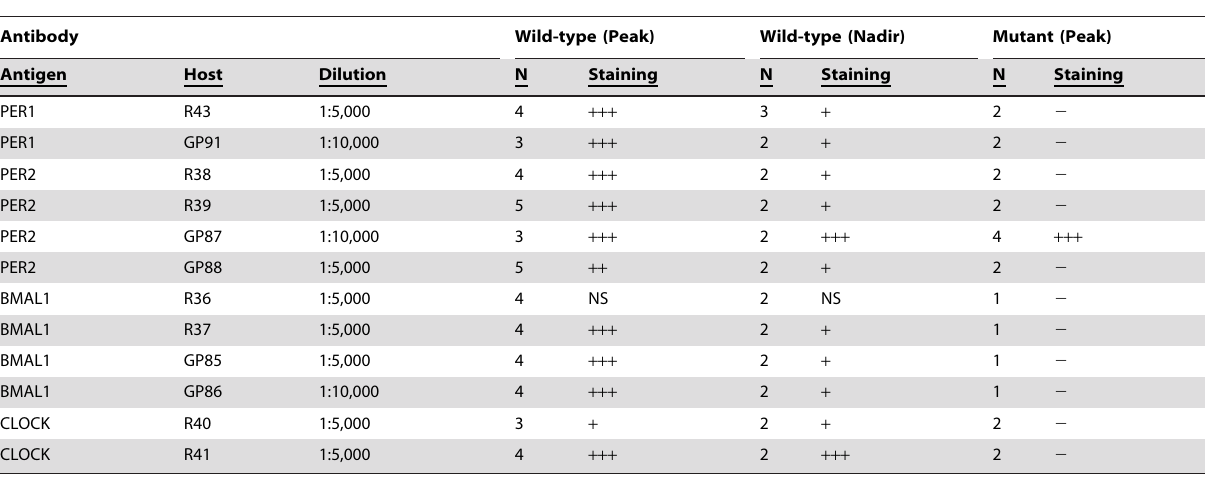
Table 2. Summary of Immunostaining Results in Wild-type and Mutant Mice.